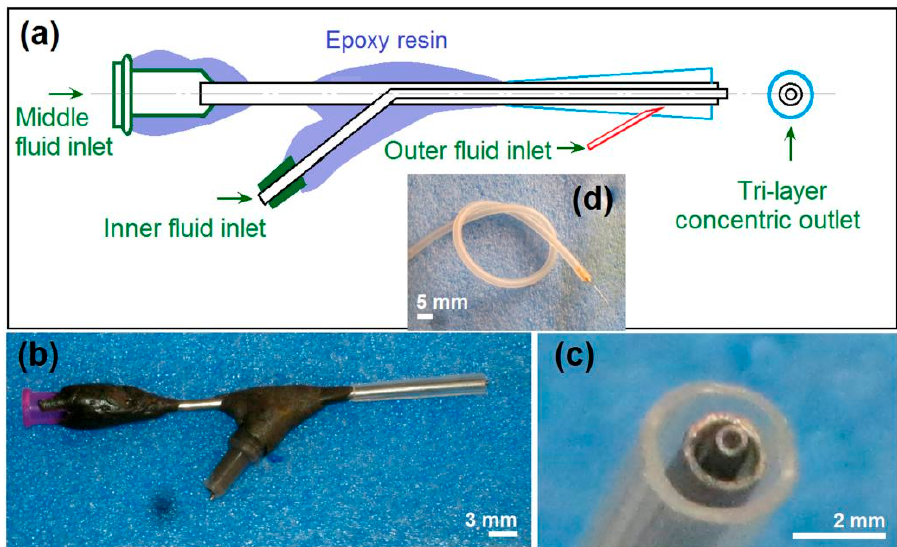
Figure 2. The detachable tri-layer concentric spinneret: ( a ) The design details of the spinneret with three inlets for the three working fluids and a common tri-layer concentric outlet; ( b ) a digital picture of the full view of the spinneret; ( c ) a digital image of the tri-layer concentric outlet. ( d ) A sharp needle with a highly elastic silica tubing for transferring the outer solvent, which has an outer diameter and a wall thickness of 0.3 and 0.05 mm, respectively.